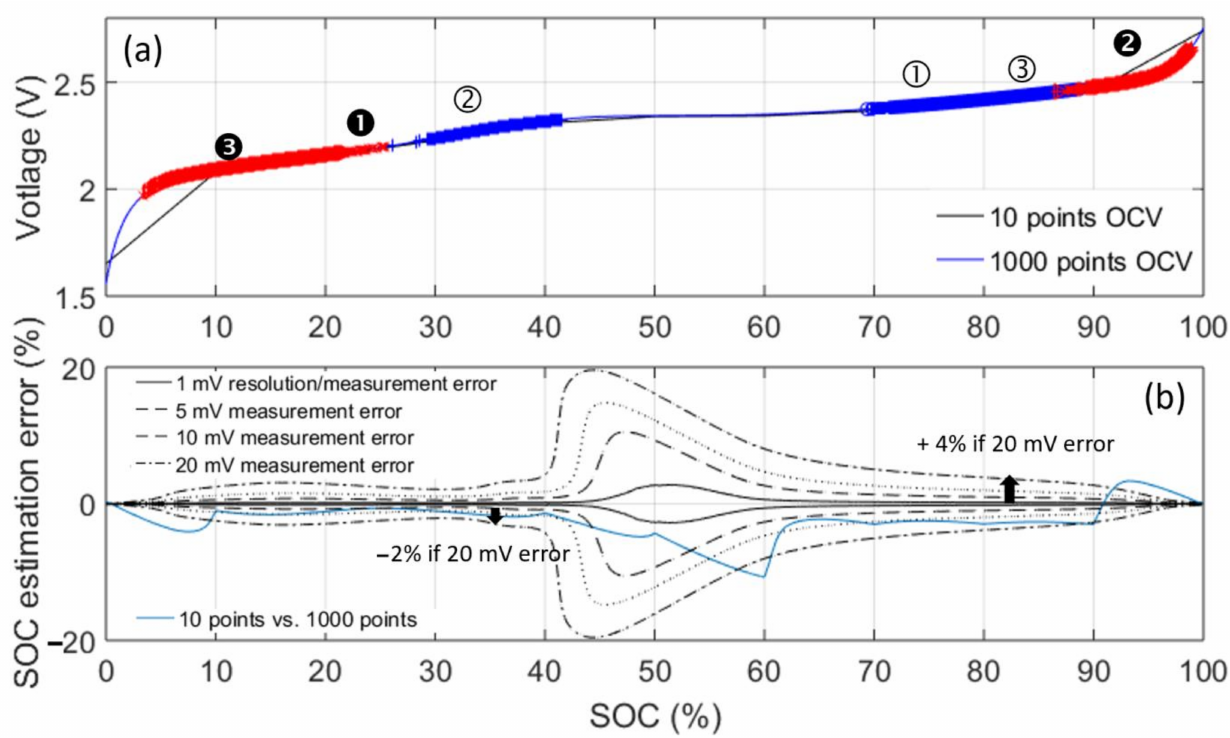
Figure 10. ( a ) Comparison of the 10 and 1000 points OCV curves with the different spread of measured RCVs. ( b ) SOC error associated with using a 10-point OCV instead of a 1000-point OCV as well as with measurement errors of 1, 5, 10 and 20 mV.